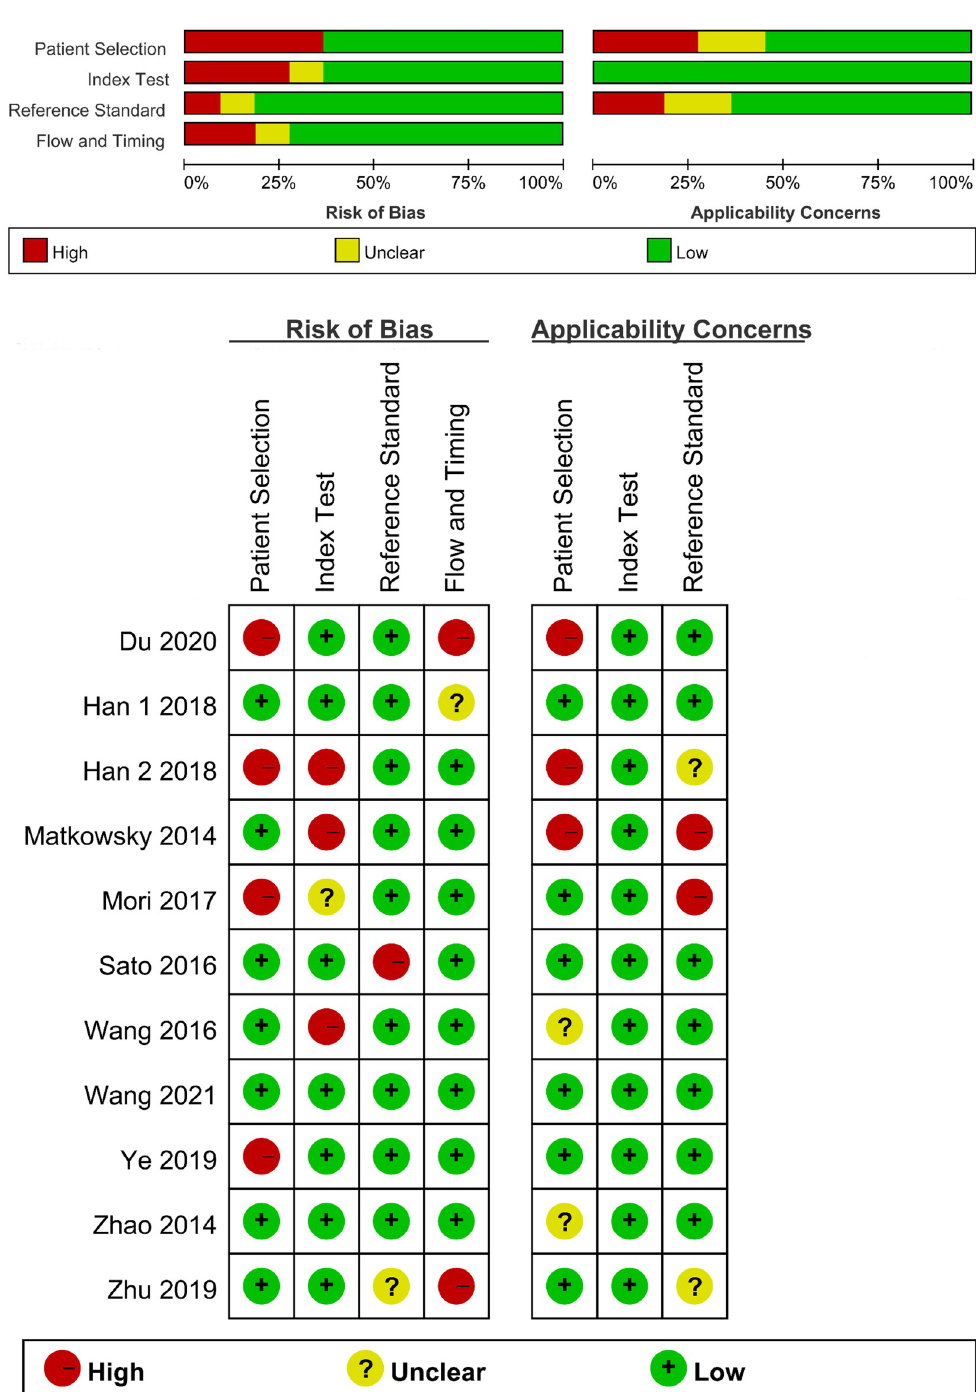
Fig 2. Overall methodology quality assessment of the included studies using the QUADAS criteria.